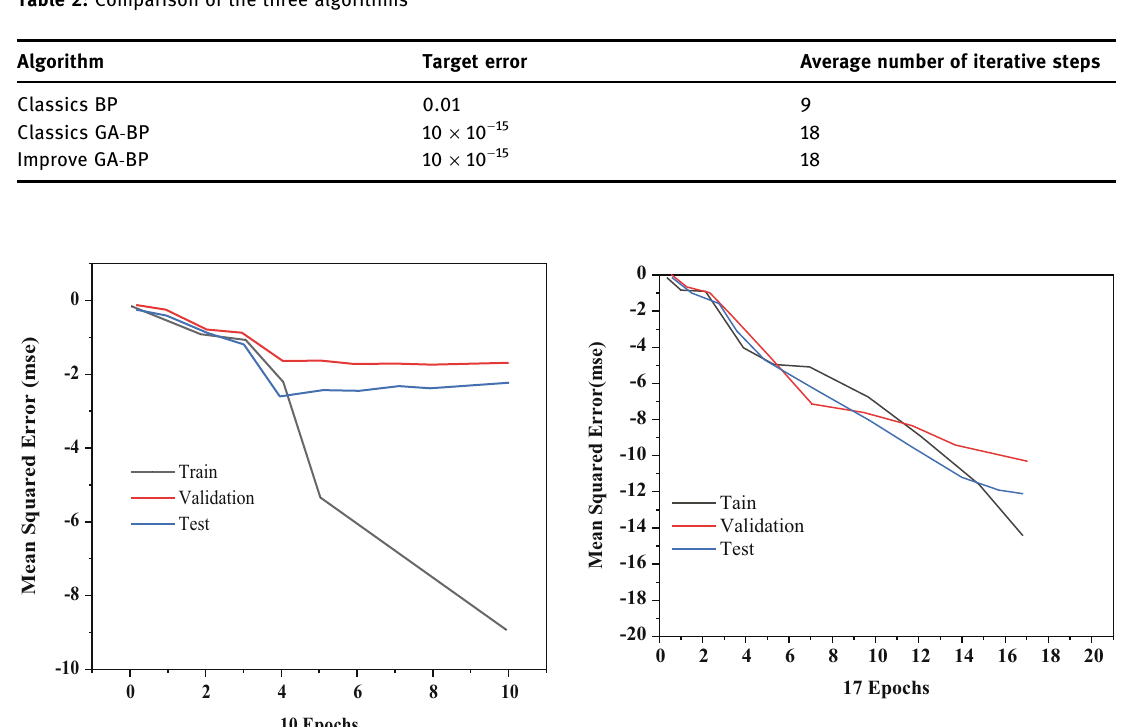
Figure 3: Convergence curve of the classical GA - BP algorithm.